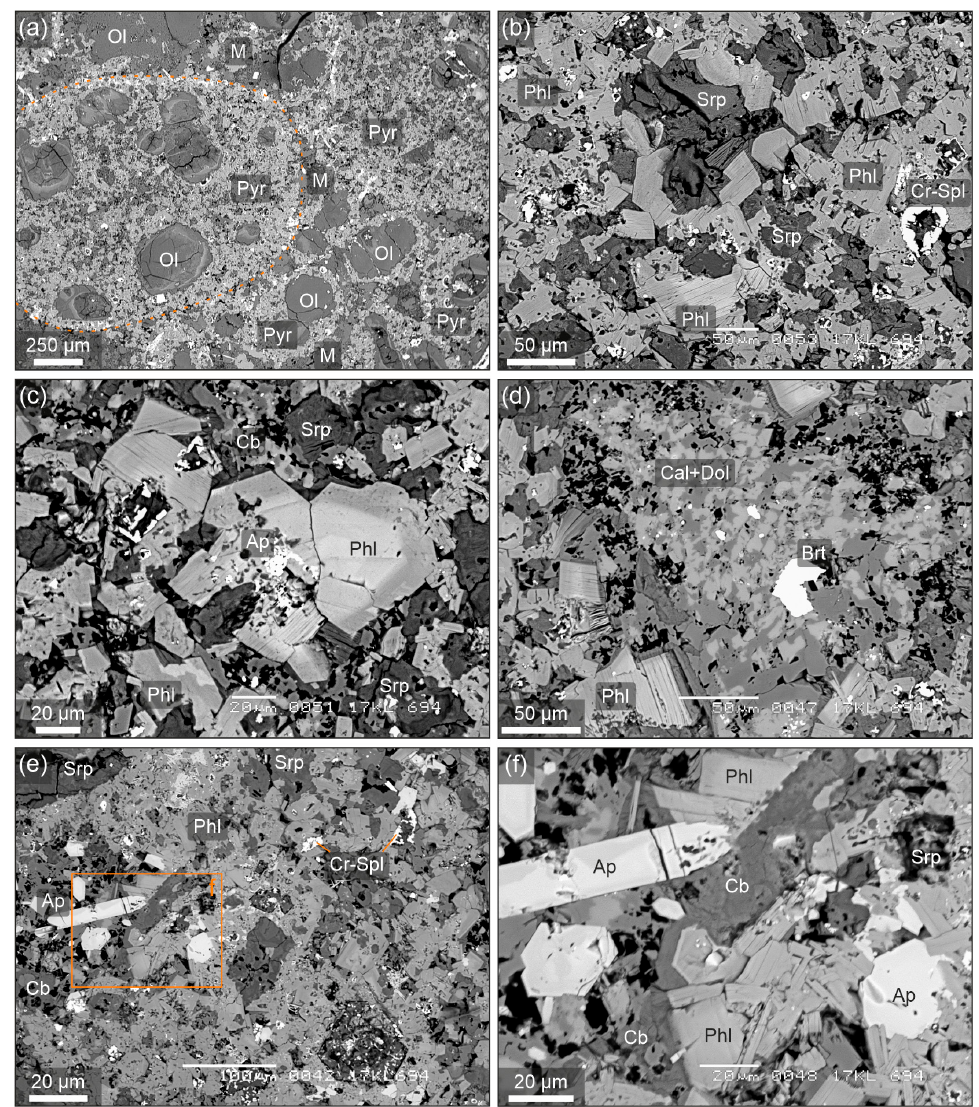
Figure 4. BSE images of massive macrocrystic kimberlite from pipe 694 (sample KLCh-694-730-222): ( a ) kimberlite magmaclasts set in the kimberlite matrix presented by magmatic kimberlites with micro-porphyry texture; ( b ) the magmaclast groundmass consists of small phlogopite grains, serpentine with minor spinel and apatite; ( c ) zoned phlogopite grains set in groundmass of magmaclast; ( d ) carbonate segregation consists of calcite and dolomite intergrowth; ( e, f ) the matrix of massive macrocrystic kimberlite. Ap—apatite; Brt—barite; Cal—calcite; Cb—carbonate; Cr-Spl—chromium spinel, Dol—dolomite; M—matrix; Ol—serpentinised olivine; Phl—phlogopite; Pyr—pyroclasts;